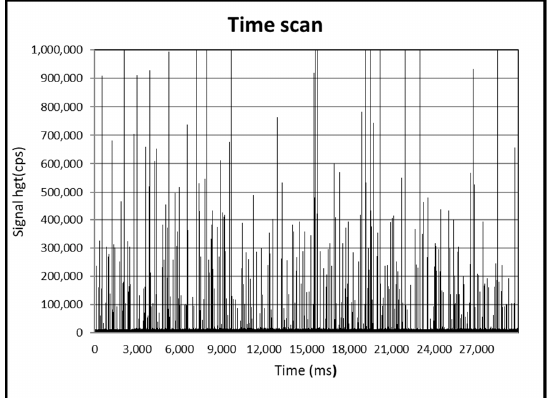
Animals 2023 , 13 , x FOR PEER REVIEW Figure 1. SpICP-MS time scans of pristine suspension of TiO 2 NPs. Figure 1. SpICP-MS time scans of pristine suspension of TiO 2 NPs.